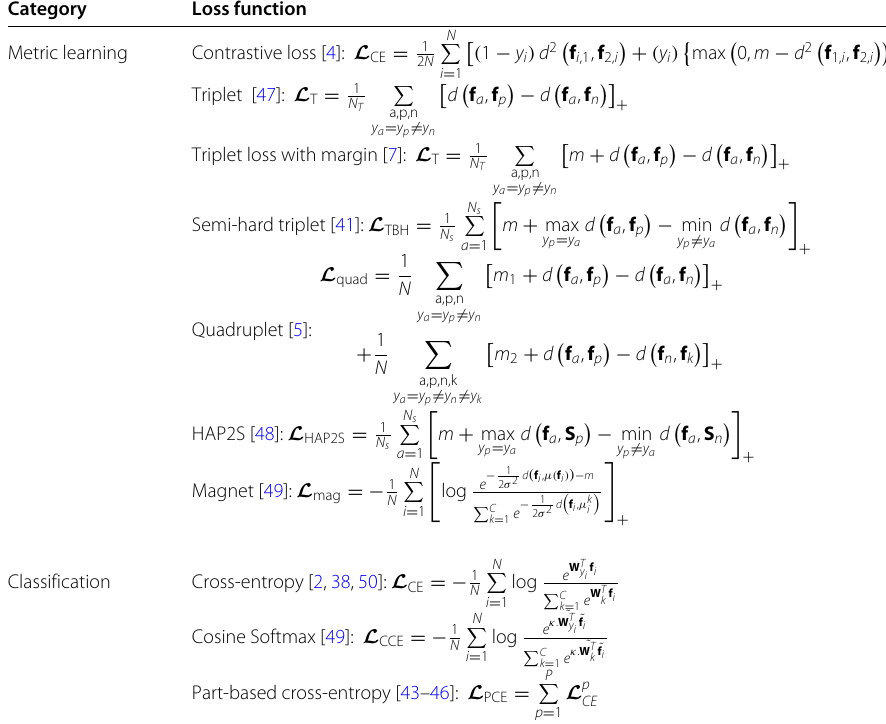
Table 1 Common loss functions applied in person ReID Category Loss function Metric